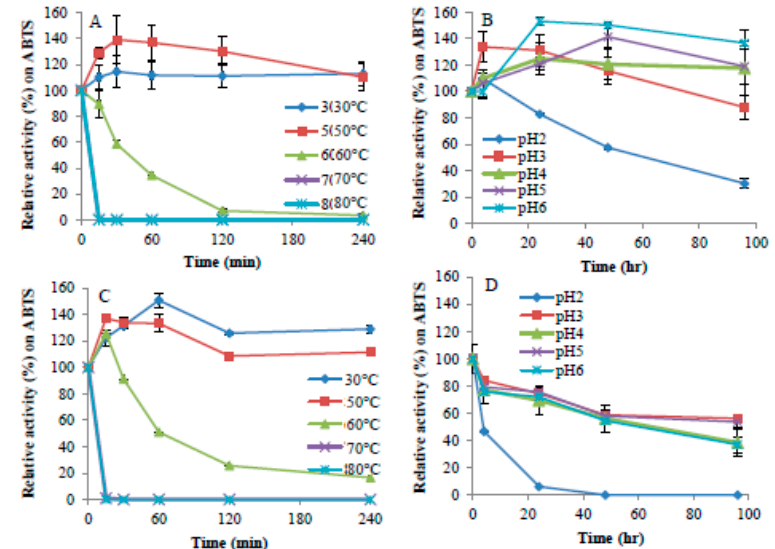
Figure 4. Thermal and pH stabilities of purified Ps Lac1 and Ps Lac2. Residual activities were estimated after 15, 30, 60, 120, and 240 min of incubation at five different temperatures ranging from 30 to 80 °C ( A , C ) or at five different pHs ranging from 2.0 to 6.0 ( B , D ) for Ps Lac1 ( A , B ) and Ps Lac2 ( C , D ). Residual activities are expressed as a percentage of the initial activity (point at time 0, measured immediately after adding the enzyme), which was set to 100%. Assays were performed using ABTS as a substrate in standard conditions. Each data point (mean +/ − standard deviation) is the result of triplicate experiments.